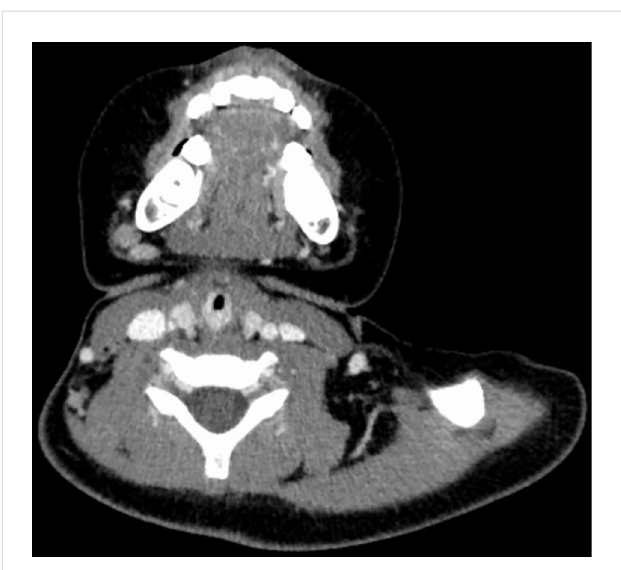
FIGURE 1 CT image of No. 8 patient before embolization treatment, with marked enhancement of hemangioma and airway